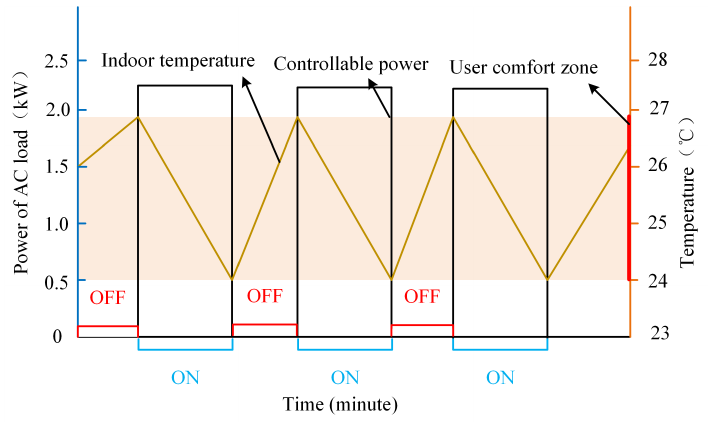
Figure 1. The intermittent characteristic of